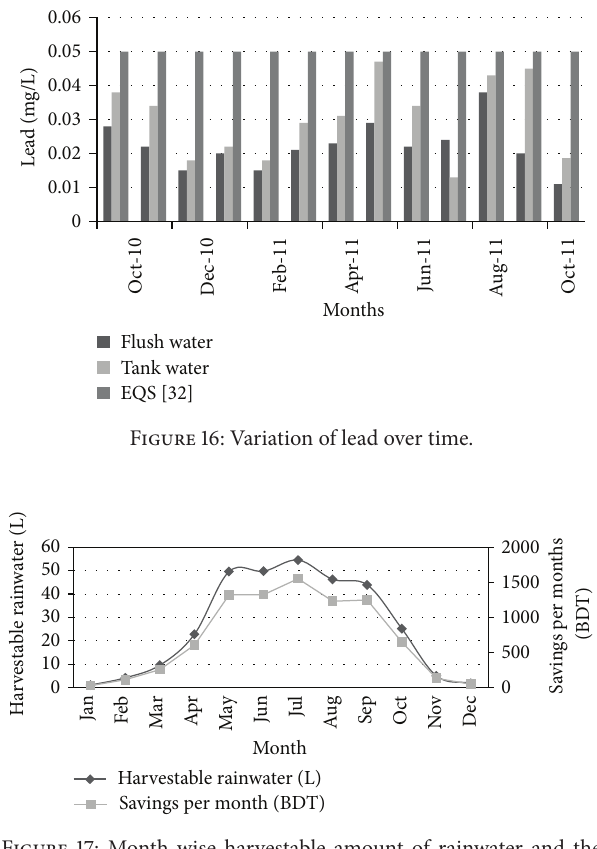
Figure 17: Month-wise harvestable amount of rainwater and the associated cost savings.